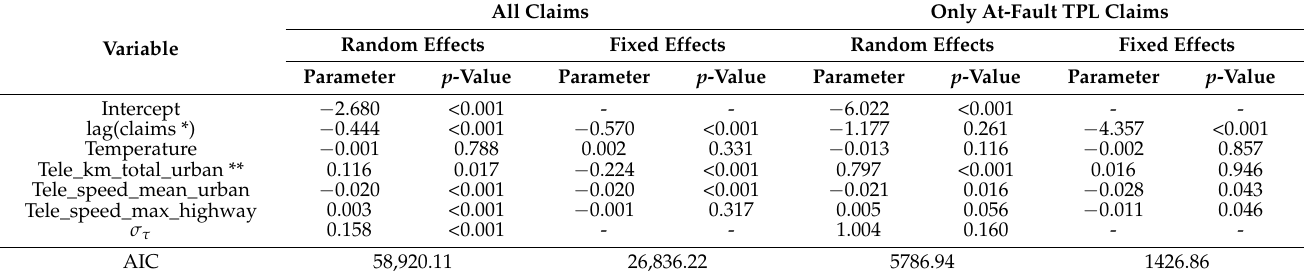
Table A3. Cross-table with the parameter estimates of random effects and fixed-effects Poisson panel data models, with p -values, for the total number of claims (left) and at-fault third-party liability (TPL) claims (right) per month and per insured based on the seven observed months in 2018 and 2019. The models consider the average monthly temperature as explanatory variable describing weather conditions.